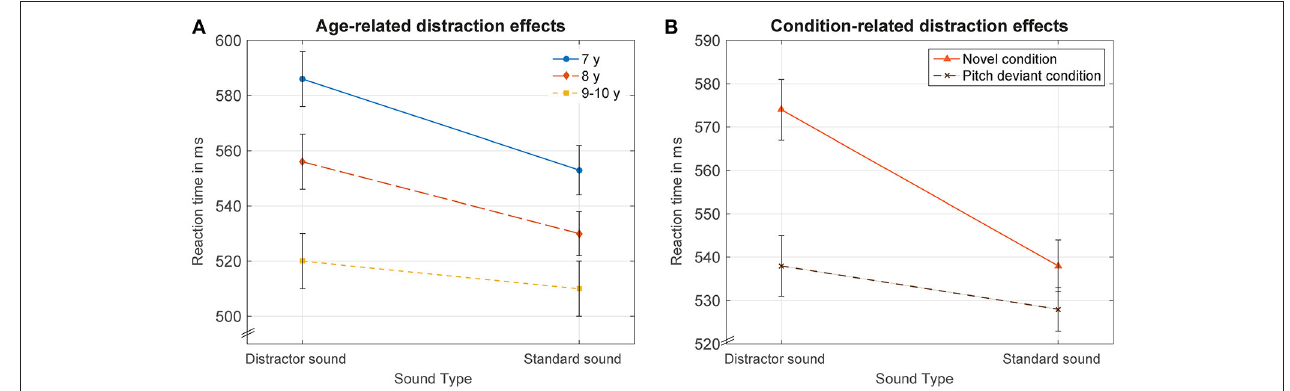
FIGURE 2 | Displays age and condition effects resulting from the statistically significant interactions of the factors sound type × age and sound type × condition . (A) Reaction times (mean over conditions) in distractor and standard trials are displayed for each age group. Reaction times were increased in distractor compared to standard trials in all age groups. This distraction effect decreased significantly with age. (B) Reaction times (mean over age) in distractor and standard trials for each condition. Novel environmental sounds caused increased reaction times compared to pitch-deviant sounds. Reaction times in response to standard sounds did not differ significantly between conditions. Error bars reflect the standard error of mean.